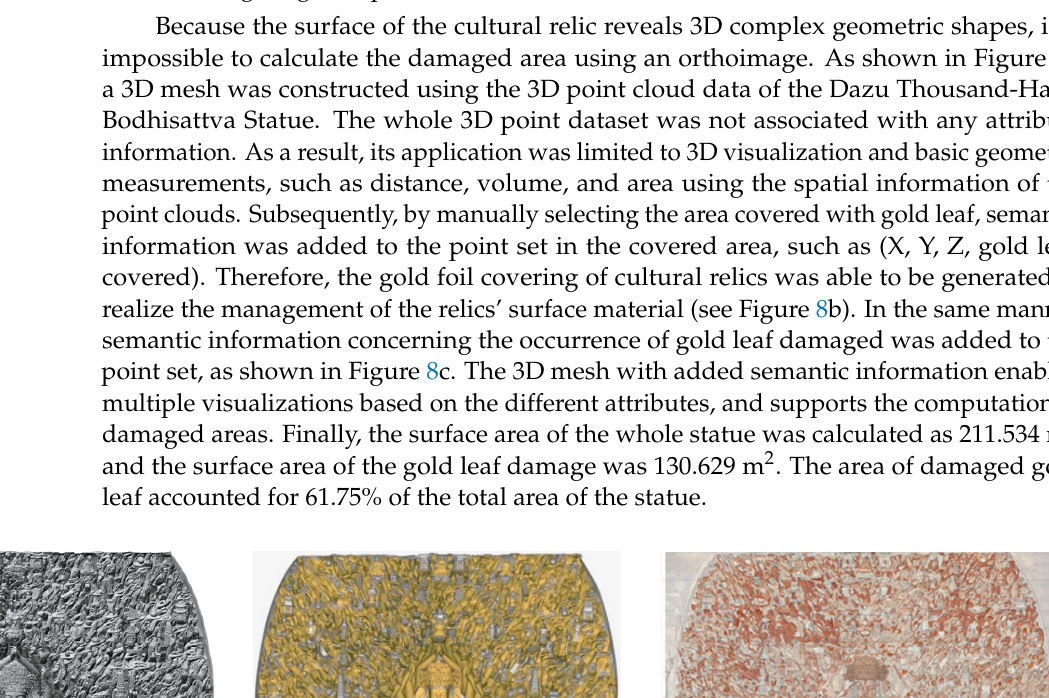
Figure 7. ( a ) LOD2—the micro-scene, comprising 3D point cloud of a Guanyin hand in 2011; ( b ) The 3D model is the result of virtual restoration, one special eye (heavenly eye) in the palm of hand and finger joints shown high ability to express geometric details.